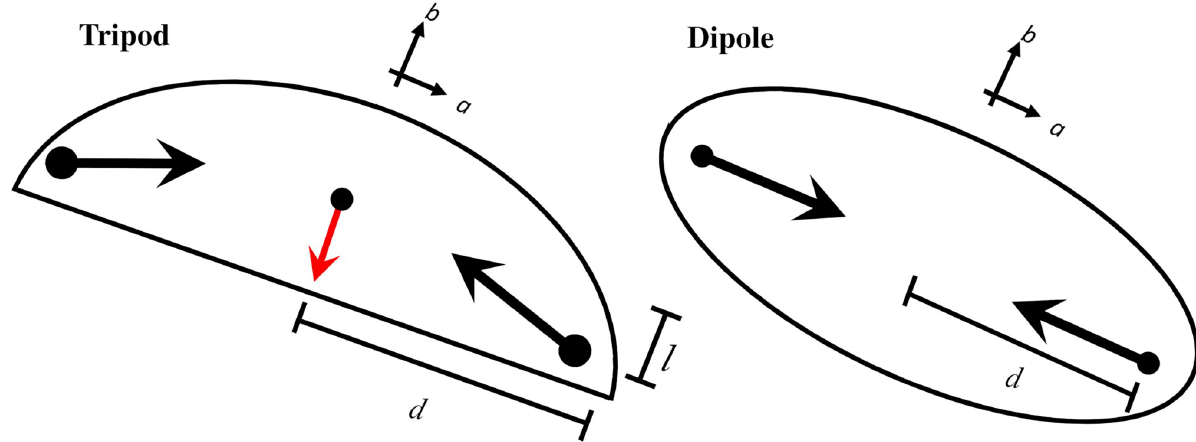
Fig 4. Sketch of the tripod force model and the dipole force model. In both cases, large opposing tractions are oriented along a which leads to a dominant traction dipole moment in that direction. In the tripod model, smaller tractions are oriented along b . In both cases, the net traction integrated over the cell area vanishes. The arrangement of the tractions for the tripod model generate a net quadrupole moment, Q aab , whereas all quadrupole moments vanish for the dipole model. The strength and relative orientation between the 2 or 3 point traction vectors are exaggerated, for clarity. Distances mentioned in the text, d and l , are shown in the figure. The cell contour is strictly illustrative.